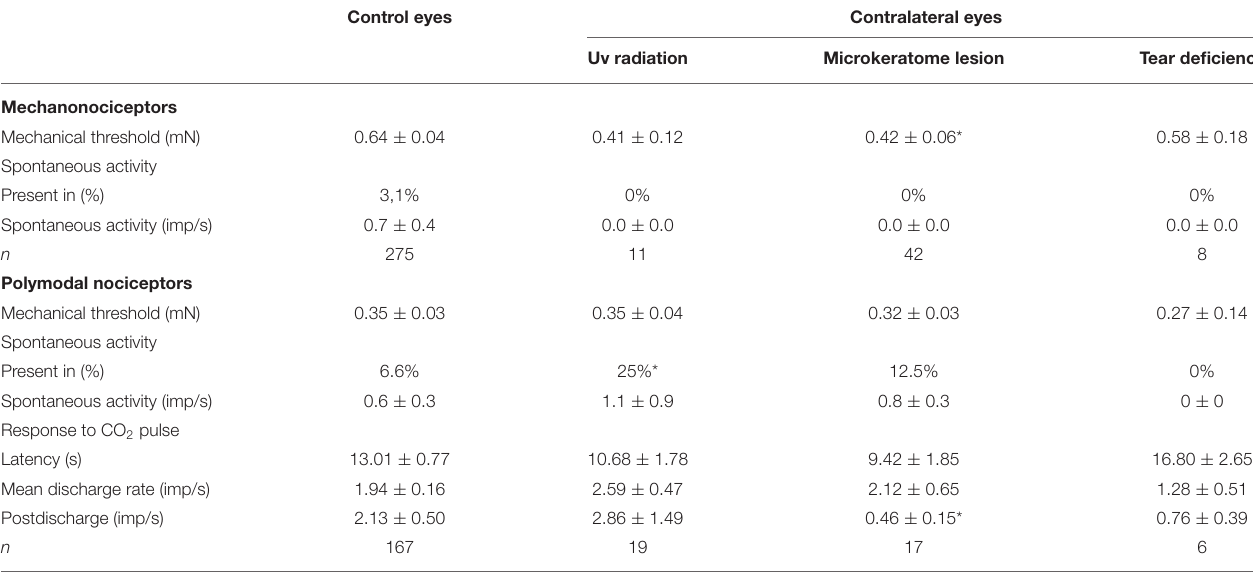
TABLE 1 | The spontaneous activity and stimulus-evoked responses of corneal nociceptors recorded in the control eyes and the eyes contralateral to UV irradiation, microkeratome lesion, or lacrimal gland removal (tear deficiency). Control eyes Contralateral eyes Uv radiation Microkeratome lesion